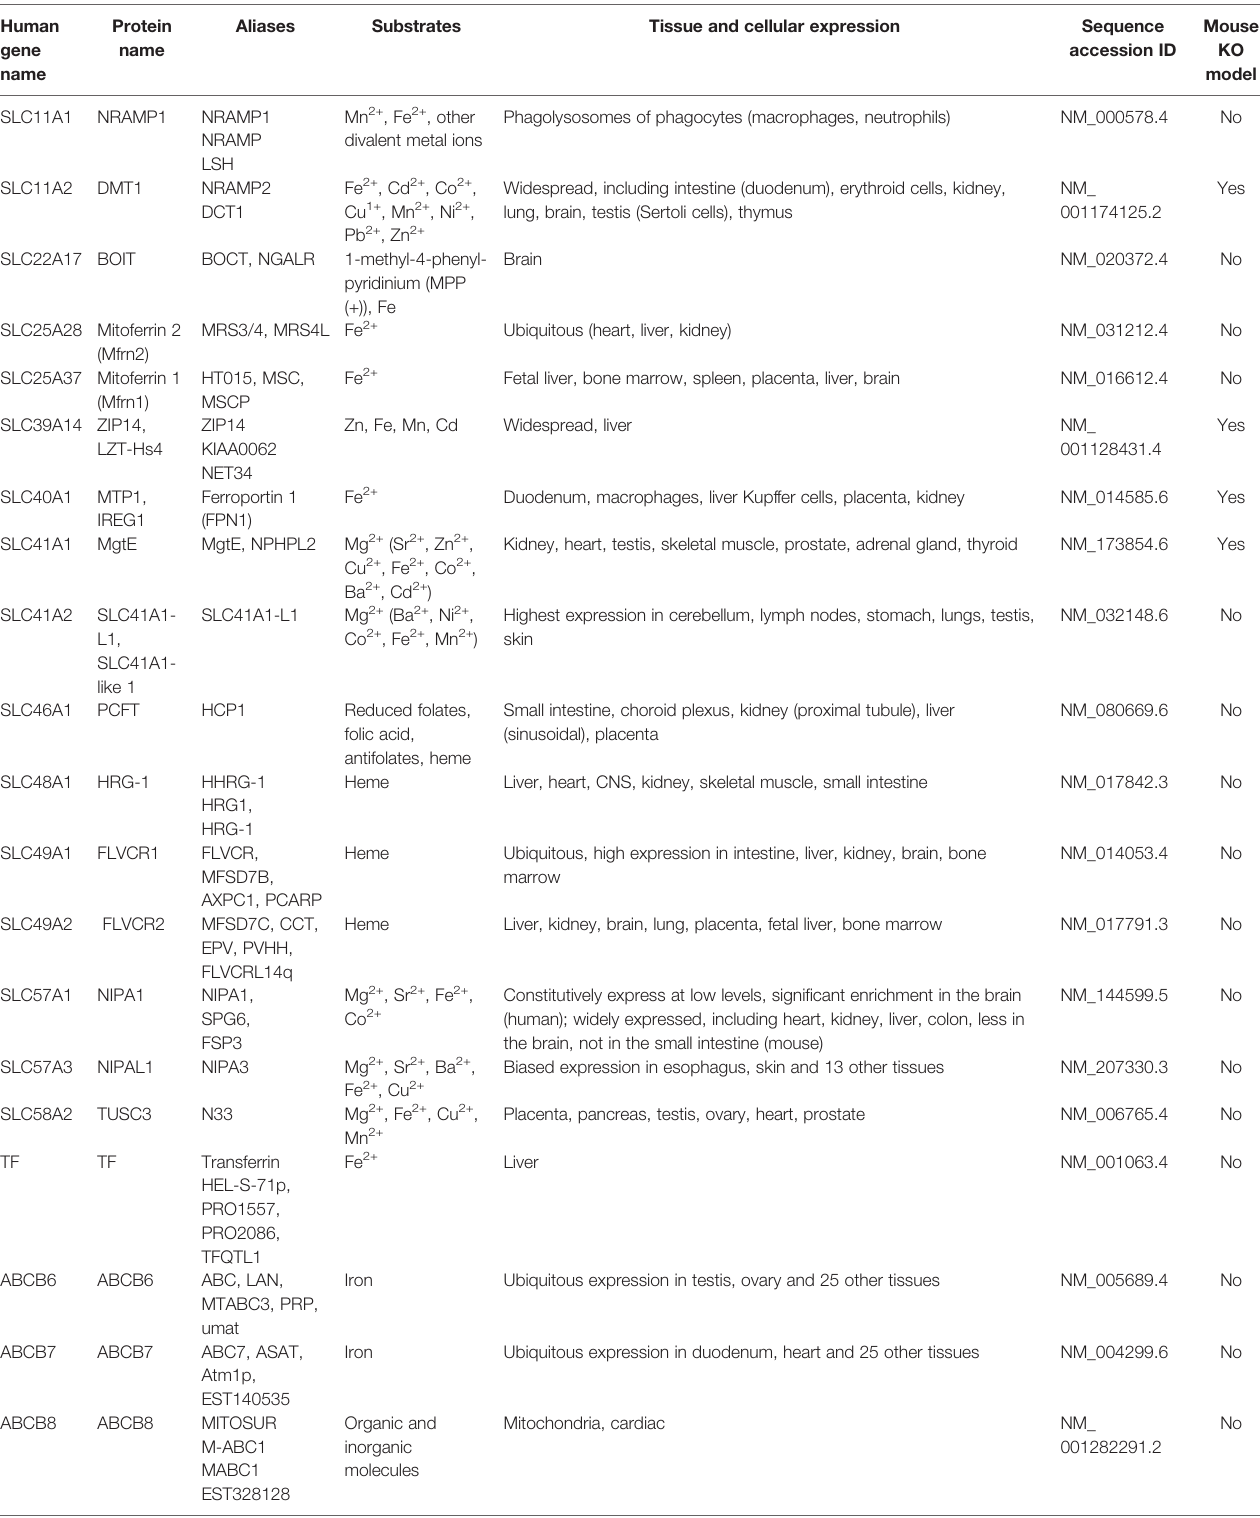
TABLE 1 | Iron Transporters. For detailed information about the gene tables, please visit: http://www.bioparadigms and http://www.org.genecards.org. Human